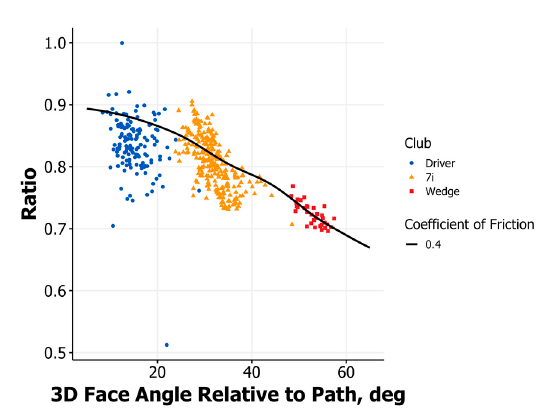
Figure 5. Launch direction ratio vs. face normal relative to club